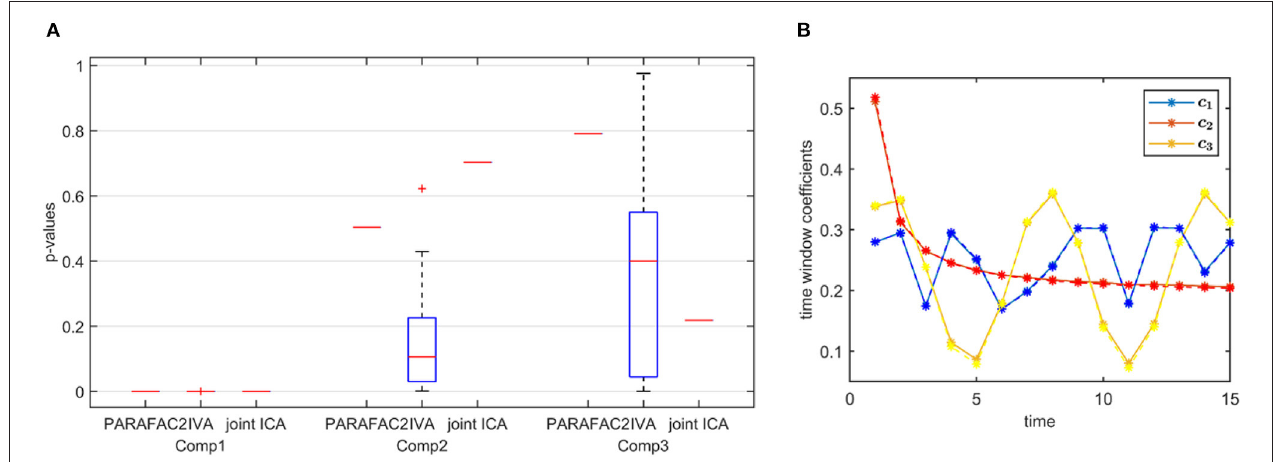
FIGURE 9 | Case 3. (A) p -values obtained using the two-sample t -test on the subject-mode patterns ( A or A k ) using different methods. Based on the true subject-mode patterns, true p -values are 0, 0.88, and 0.35 for component 1, 2 and 3, respectively. All methods identify the first component as the component differentiating between the subject groups. While PARAFAC2 and joint ICA identify the second and third components as not statistically significant in terms of group difference, IVA wrongly identifies them as statistically significant in some windows. (B) Temporal patterns, i.e., columns of factor matrix C , extracted from the time mode using PARAFAC2. True patterns are shown using dashed lines. PARAFAC2 correctly captures the true temporal patterns.